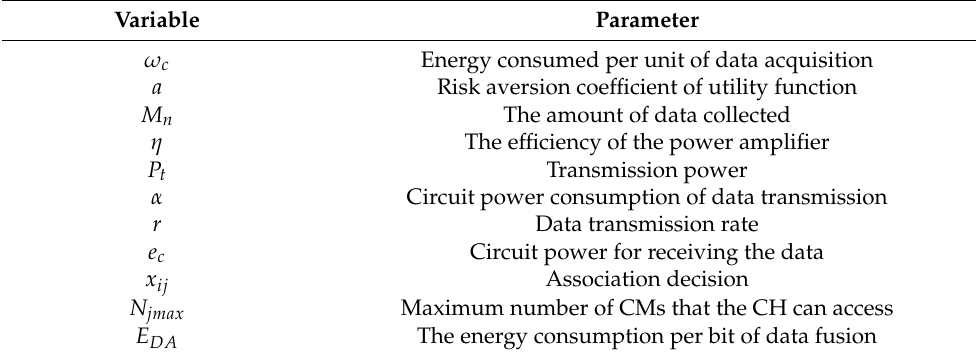
Table 1. The key